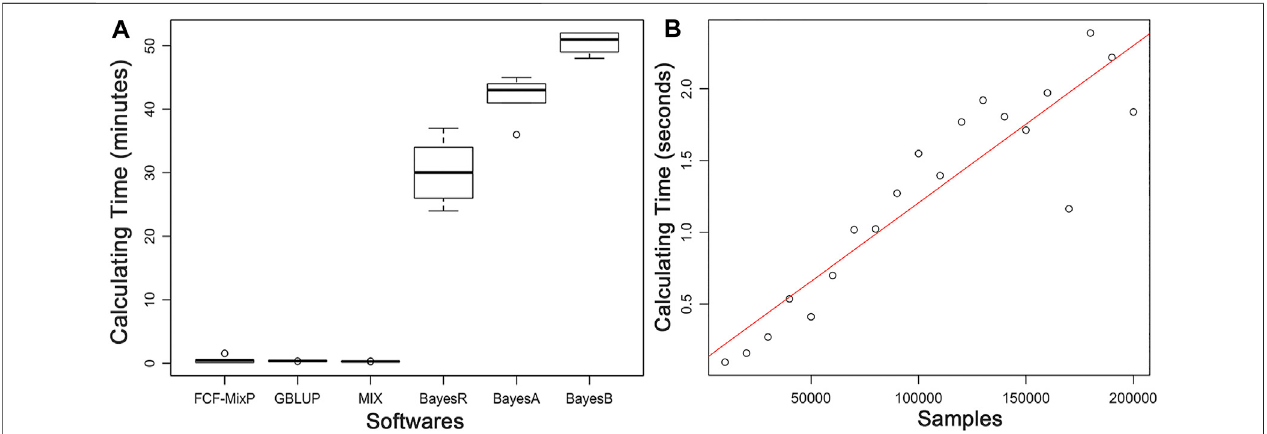
FIGURE 2 | (A) . Comparison of computing performances (in min) of FMixFN, GBLUP, MIX, BayesR, BayesA, and BayesB at fi rst cross-validation of the six traits. Computing performance tests were performed in a Red Hat Enterprise Linux server with 2.80 GHz Intel(R) Xeon(R) 20CPUs E5-2680 v4, and 66 GB memory. (B) . The computational time (in s) for per iteration of FMixFN according to the number of individuals increasing in the reference group. Computing performance tests were performed on a Red Hat Enterprise Linux server with 2.10 GHz Intel(R) Xeon(R) 64 CPUs Gold 6130, and 131 GB